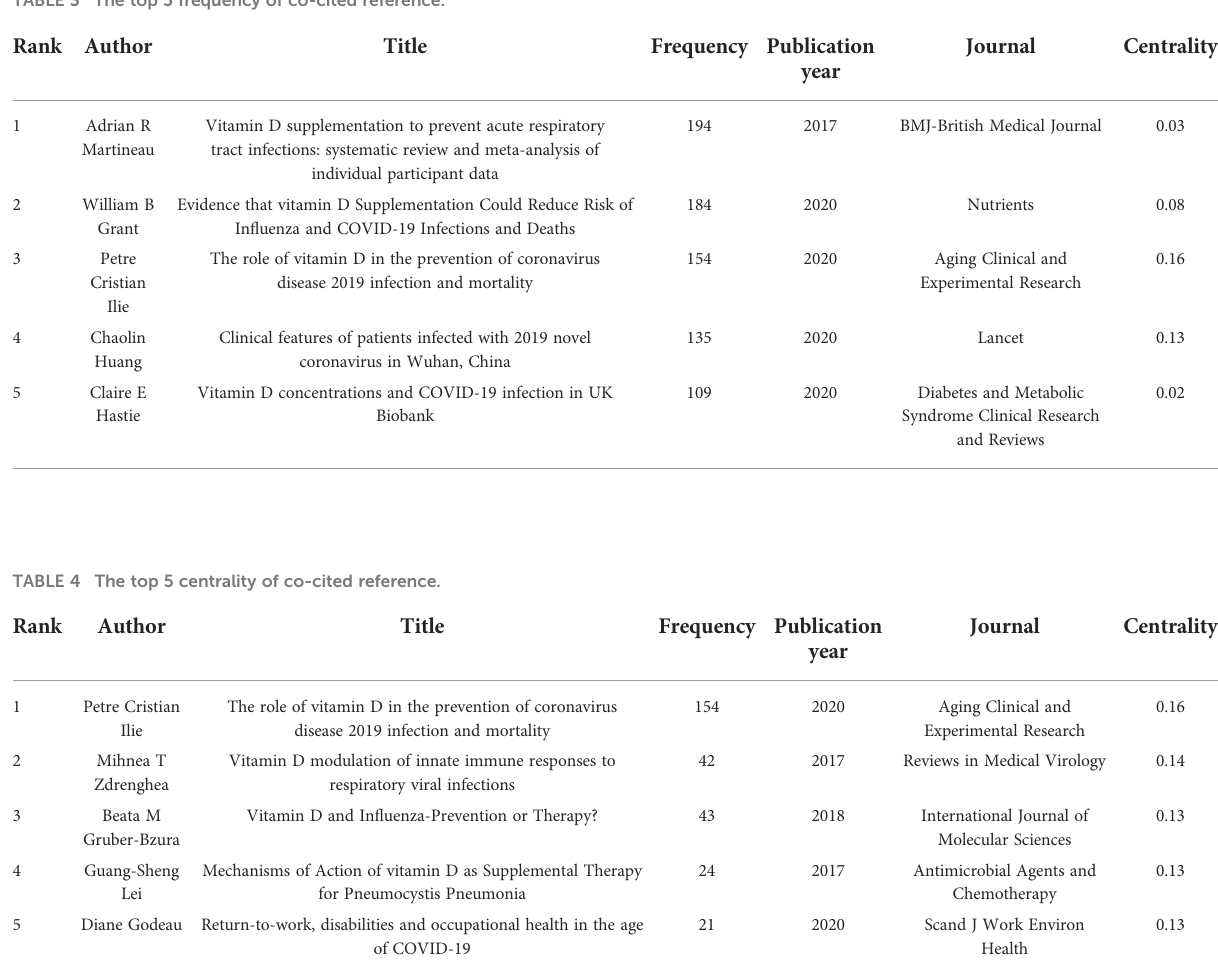
TABLE 3 The top 5 frequency of co-cited reference.